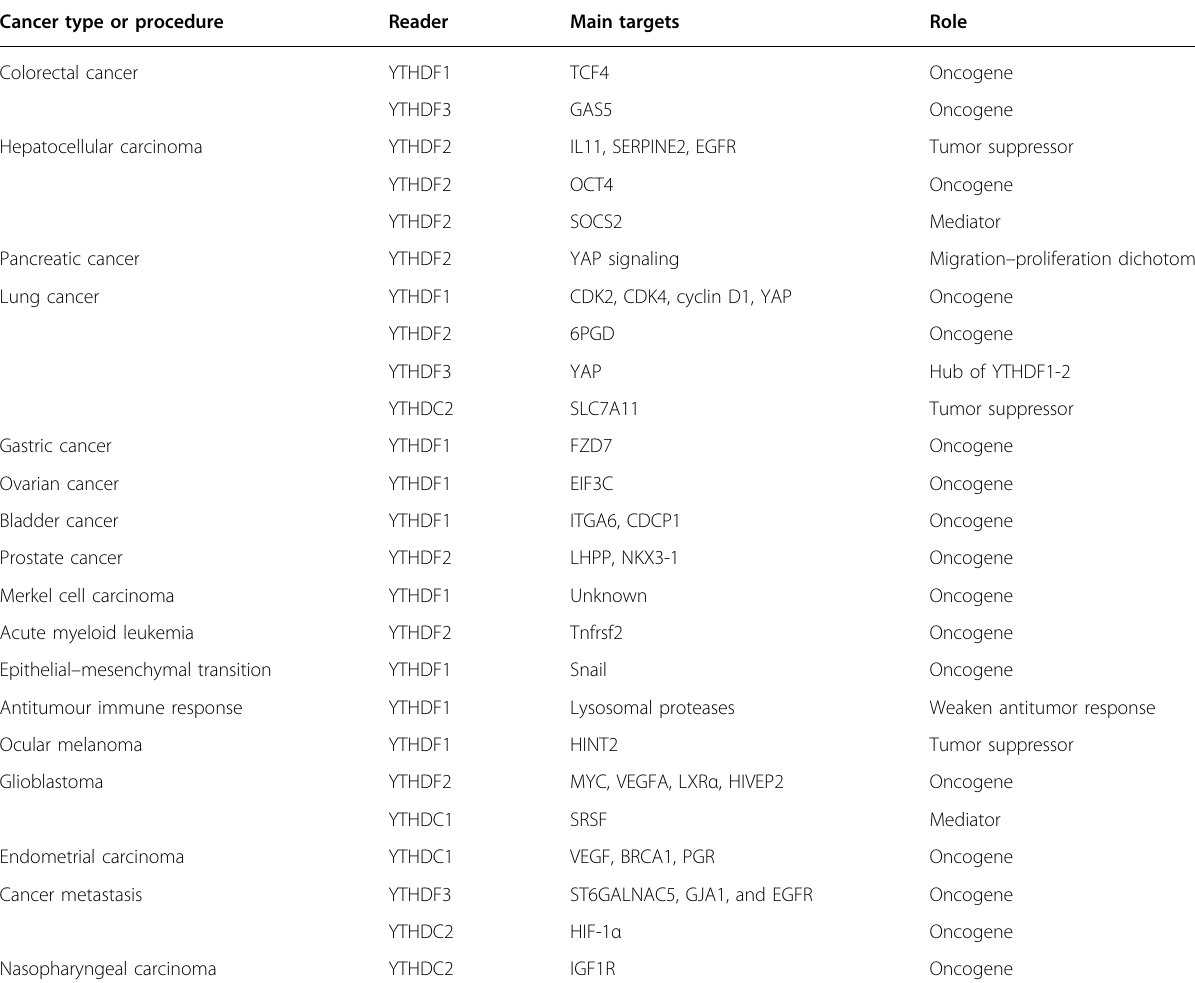
Table 3 List of the roles of YTH family proteins in different